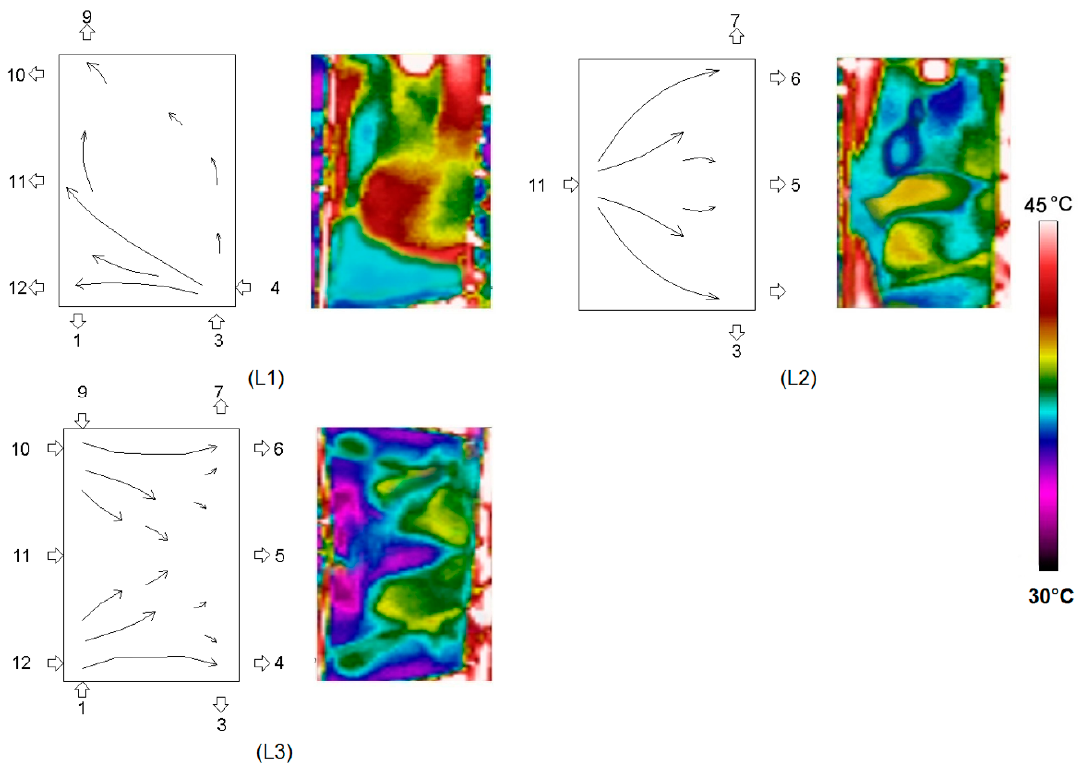
Figure A3. Diagrams of expected flow lines for group L configurations, alongside their respective thermographic images. The reader is referred to Table 2 for the description of each configuration.